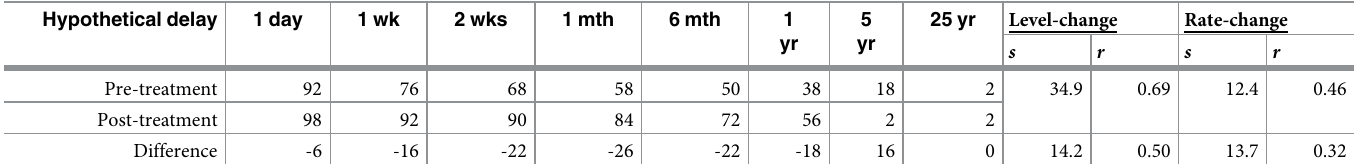
Table 5. Example of indifference points from discounting tasks completed pre- and post-treatment for opioid dependence by Patient 1390. Hypothetical delay Pre-treatment Post-treatment